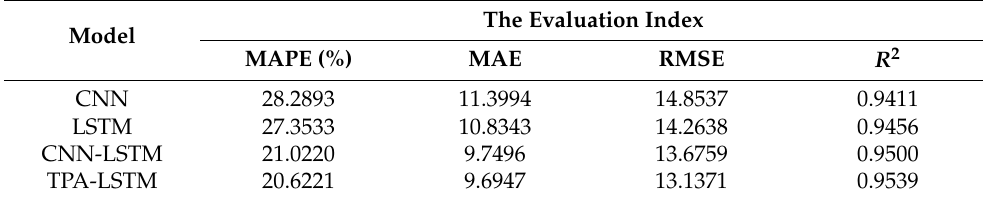
Table 5. Error analysis of prediction results of each model in Xinfeng station.